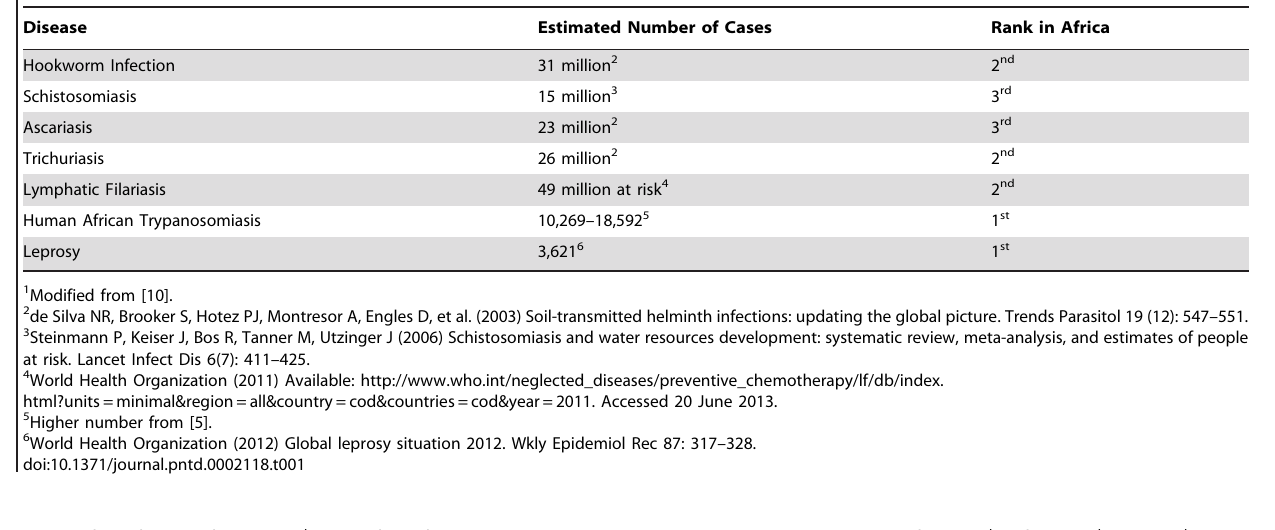
Table 1. NTDs in DR Congo 1